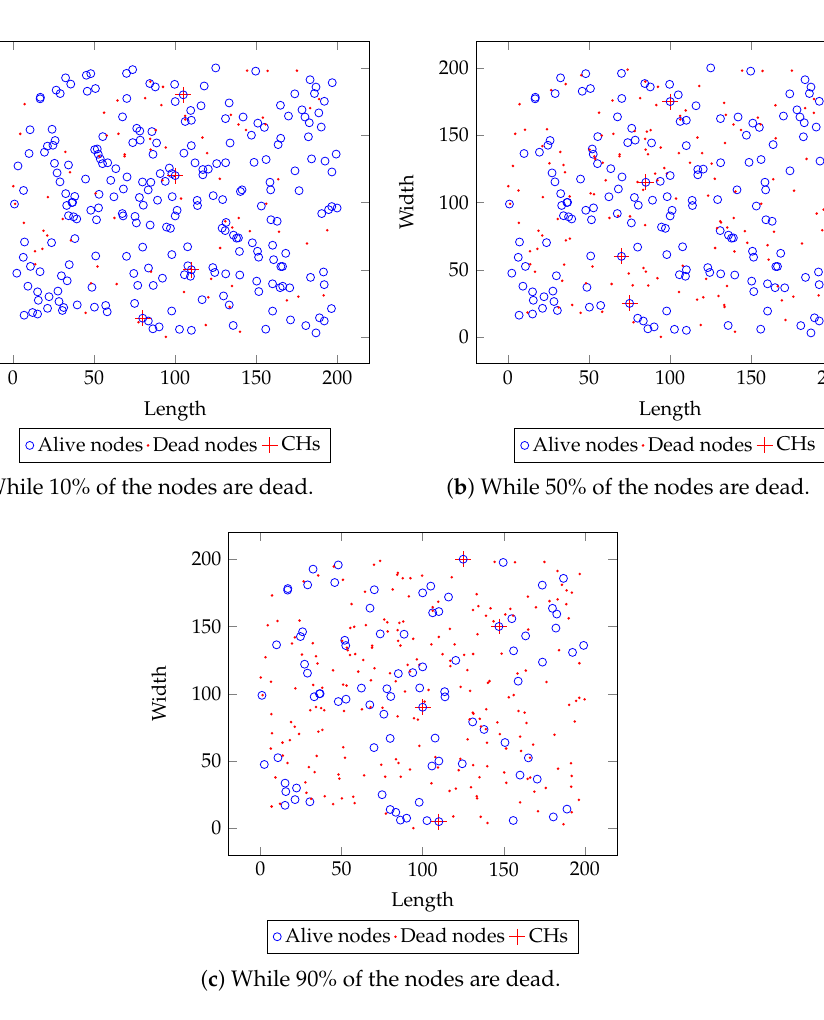
Figure 10. The distribution of dead and alive nodes in the network with the proposed